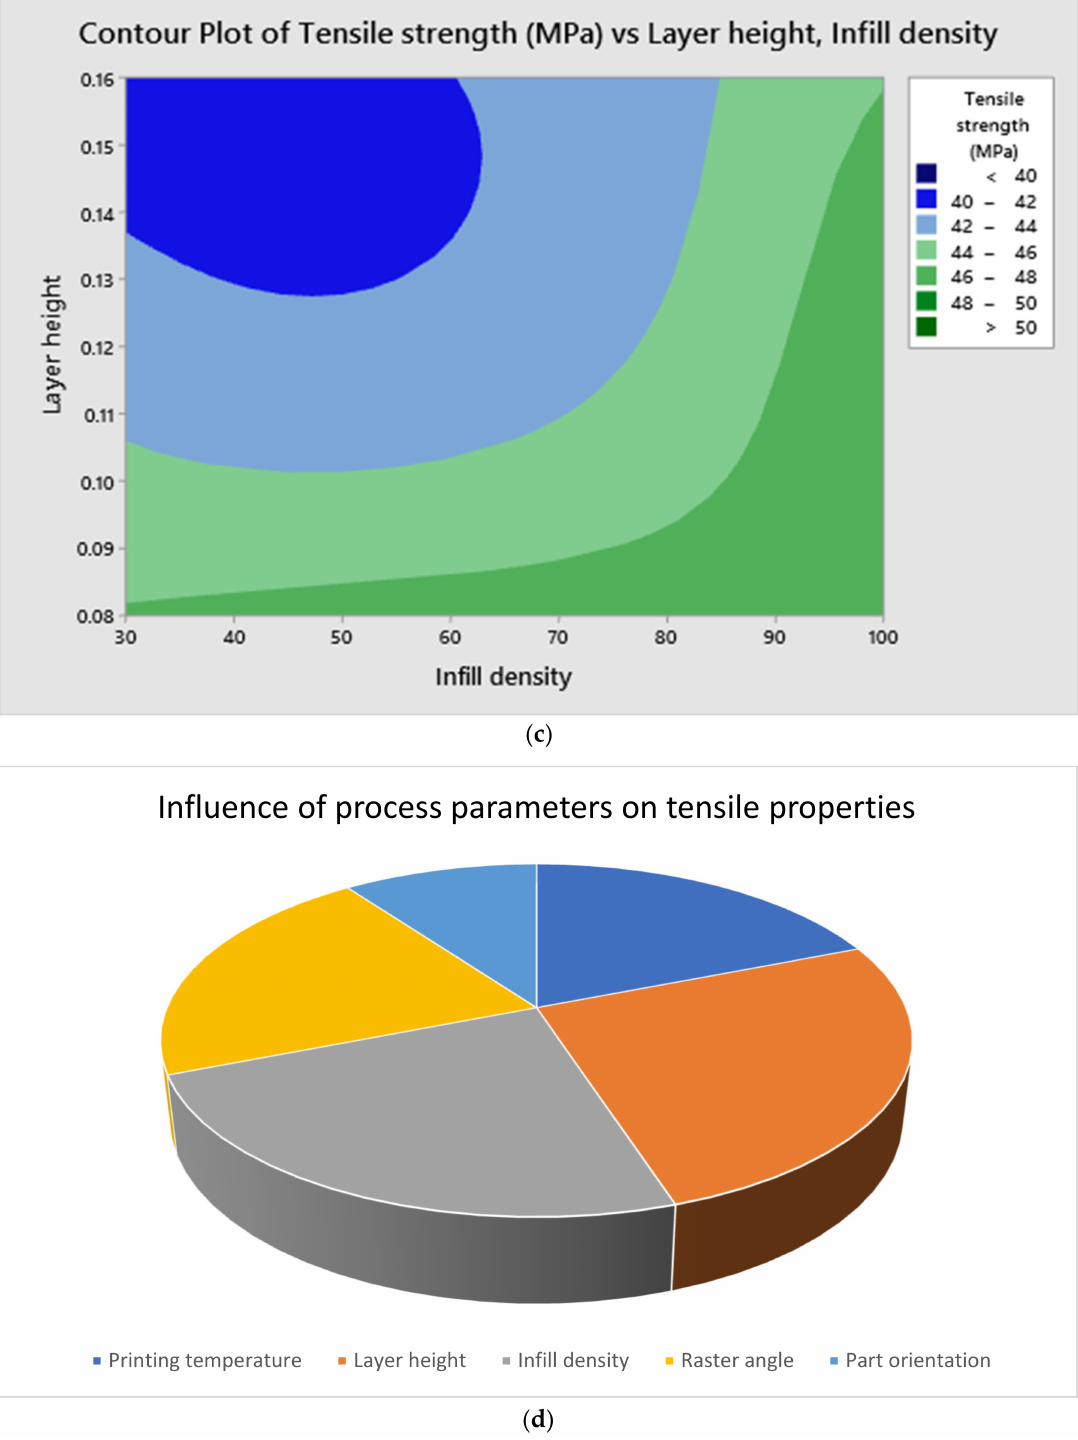
Figure 15. ( a ). Main effects plot for tensile test responses. ( b ). Interaction plot for tensile test responses. ( c ). Contour plot for maximum tensile strength. ( d ). Contribution plot of parameters for tensile